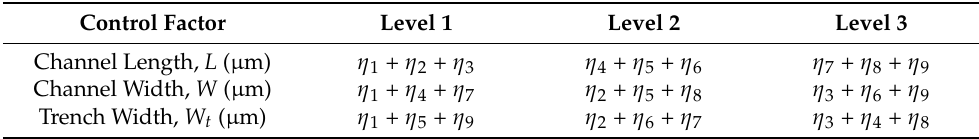
Table 4. S/N ratio equation for each level of the control factors.